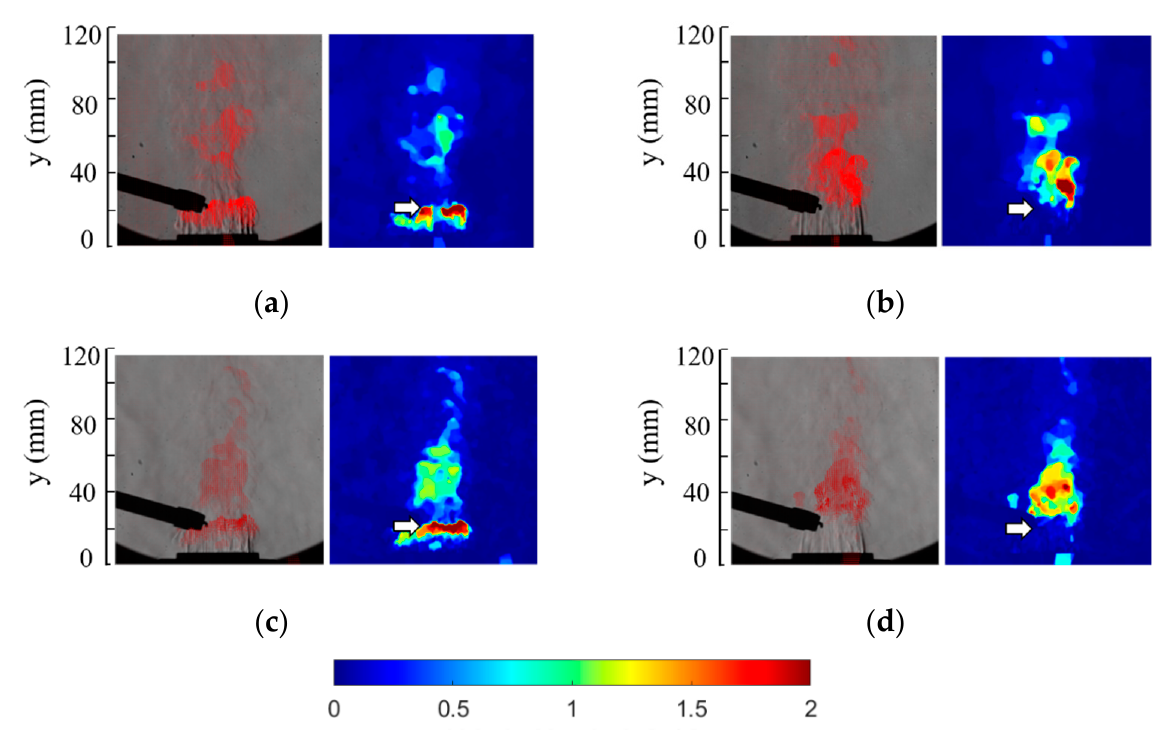
Figure 9. Velocity vectors and velocity contours for: ( a ) ignition failure of 30 Hz; ( b ) ignition success of 30 Hz; ( c ) ignition failure of 50 Hz; ( d ) ignition success of 50 Hz (the white arrow in velocity contours represents the position of ignition).